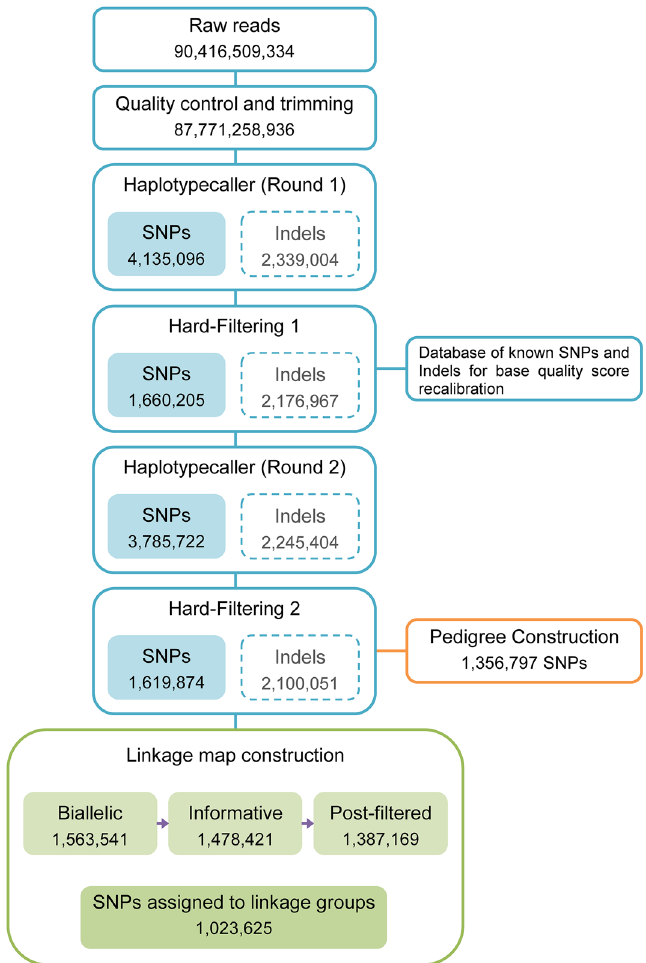
Figure 1. Pipeline showing the number of variants involved in the different steps. SNPs hard-filtering criteria: QualByDepth (QD) < 10.0, Quality (QUAL) < 30.0, StrandOddsRatio (SOR) > 3.0, FisherStrand (FS) > 60.0, RMSMappingQuality (MQ) < 40.0, MappingQualityRankSumTest (MQRankSum) < -12.5 and ReadPosRankSumTest (ReadPosRankSum) < -8.0. Indels hard-filtering criteria: QualByDepth (QD) < 2.0, Quality (QUAL) < 30.0, FisherStrand (FS) > 200.0 and ReadPosRankSumTest (ReadPosRankSum) < -20.0.